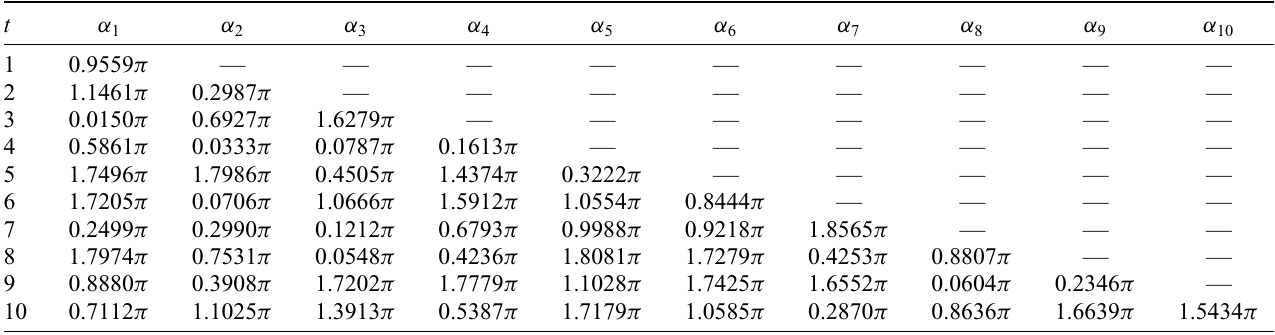
TABLE III. The randomly chosen values of α k used in the experiment to study the effect of symmetry protection on experimental error. The result is presented in Fig.